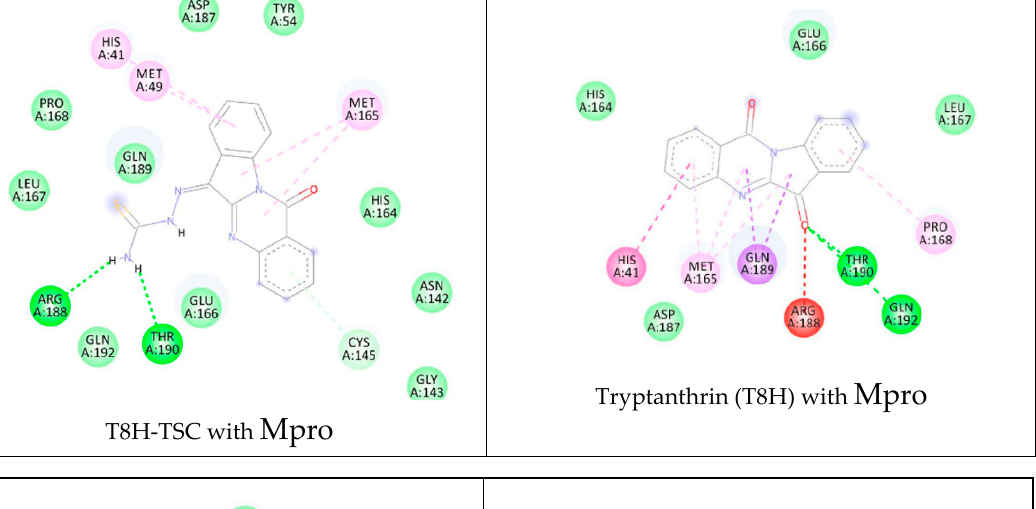
Figure 18. Comparison of M pro with tryptanthrin derivates (TSC compounds, the left side of figure) with tryptanthrin and PAA (right side). During the creation of the magnified image, the hydrogen atoms were hidden for aesthetic reasons.